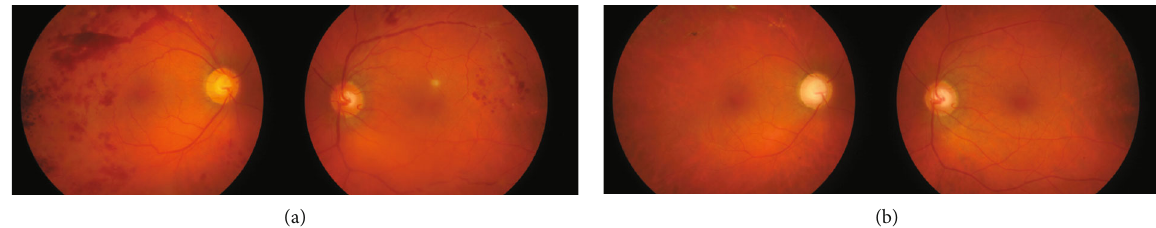
Figure 2: Image of ocular fundus showing (a) active venous vasculitis with hemorrhages in all retinal quadrants in both eyes in patient 2 and (b) after treatment, including scatter laser photocoagulation and intravitreal anti-VEGF